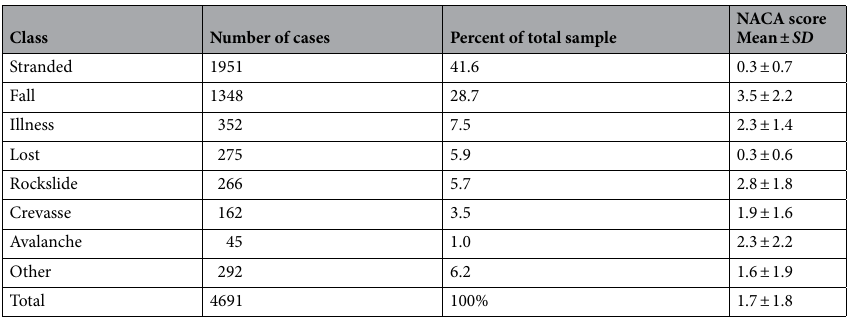
Table 1. Overview of mountain emergencies. “Other” included causes such as lightning strikes, equipment failures, and cases where no cause was listed. There was a statistically significant difference in NACA scores (F(8, 4753) = 578.1, p < 0.01). The Ganges–Howell test for multiple comparisons revealed a significant difference between being stranded and all the other classes except for being lost, which implies that the